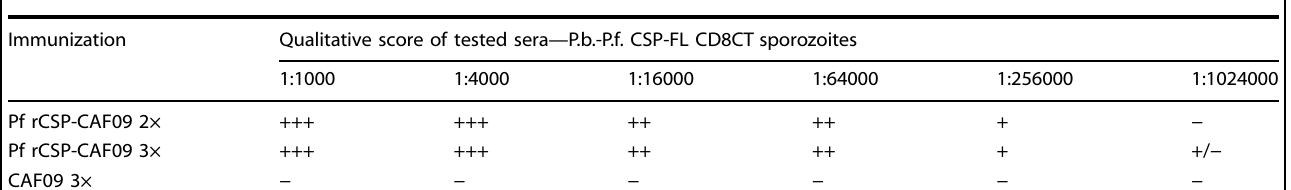
Pooled serum samples from mice immunized two or three times ( n = 6/group) with Pf rCSP-CAF09 were incubated on slides coated with fi xed sporozoites and stained with fl uorescently labeled anti-mouse secondary antibody. Slides were qualitatively scored under a microscope +++, strong;++, good;+, weak; and −